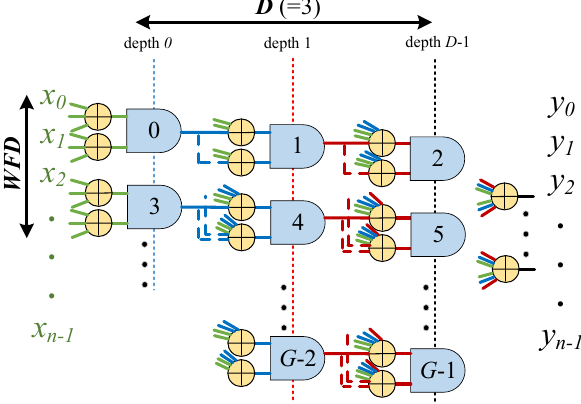
Figure 5: Generated circuit structure by Algorithm 1 for the SAT